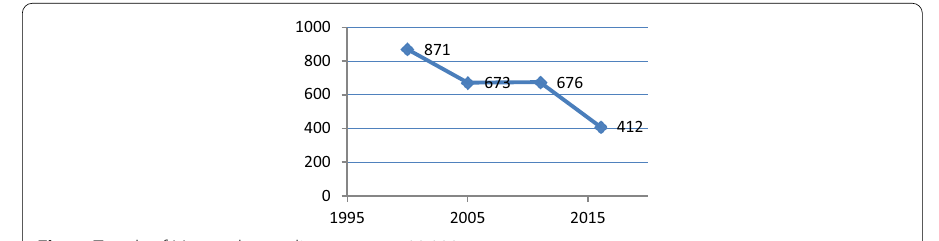
Fig. 1 Trends of Maternal mortality rates per